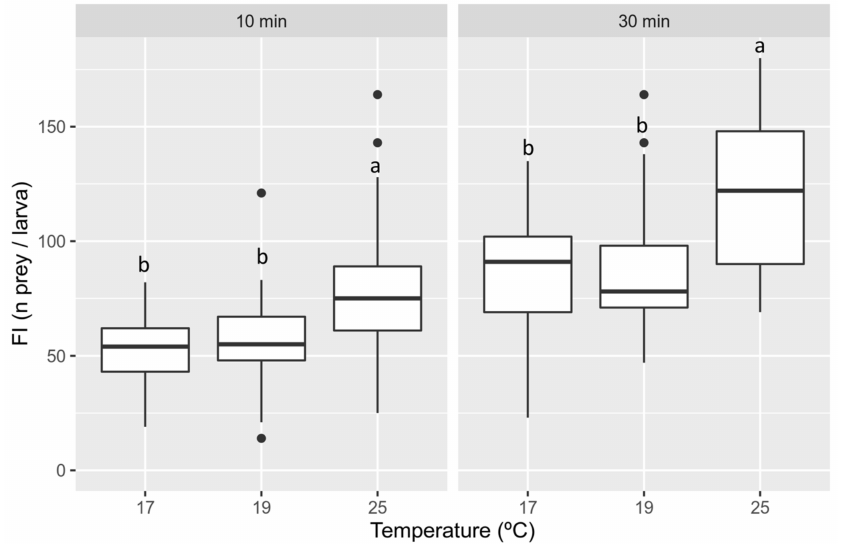
Figure 6. Feeding intensity of Sparus aurata larvae aged 41 days post-hatching (DPH), after 10 and 30 min of being fed at 17, 19, and 25 ◦ C. Different letters represent significant differences among temperatures (Kruskal–Wallis, p < 0.05, followed by paired comparisons using Mann–Whitney U test, p < 0.05), whereas asterisk represents differences between 10 and 30 min for each temperature (Mann–Whitney U, p < 0.05). Boxplot: black horizontal line represents the median, the lower and upper whites boxes represent 1st and 3rd quartile, the inferior and superior extremes of whiskers represent minimum and maximum values, respectively, and the black dots represent